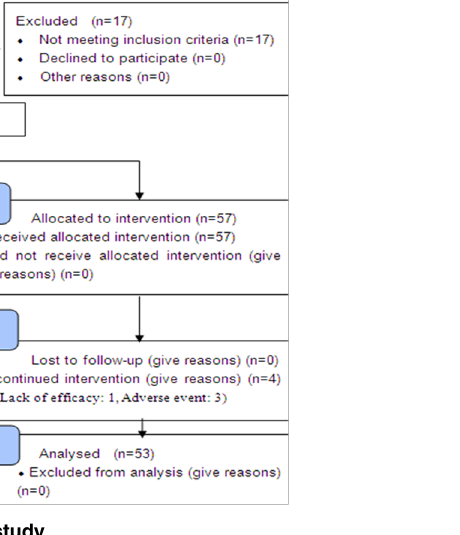
Fig 1. Flow chart of participants through the